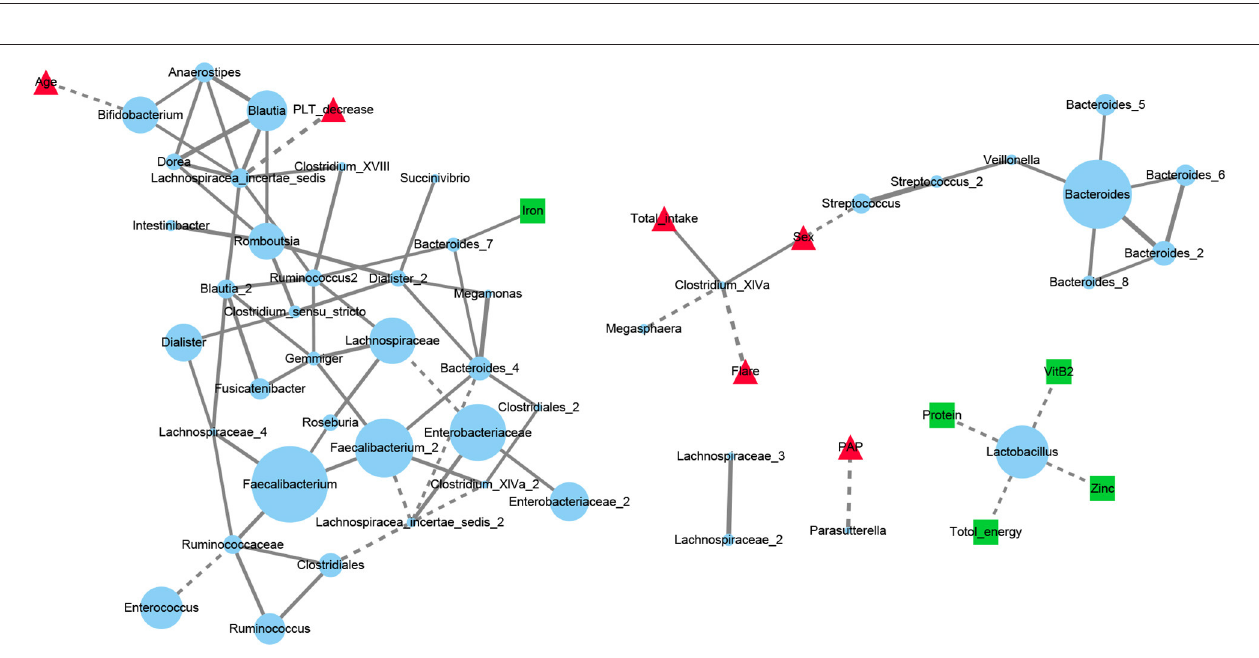
FIGURE 4 | Volcano plot comparing SLE and HC gut microbiota. The genus abundances of all SLE recipients (A) or lupus nephritis (LN) subgroup (B) were compared with healthy controls. Wilcoxon p-values were calculated and adjusted by the FDR method. Each dot represented a genus. Significantly increased genera of SLE group were plotted and annotated in red, while decreased in blue. The X axis represents the log2 values fold change and the Y axis represents the –log10 value of the adjusted p -values.